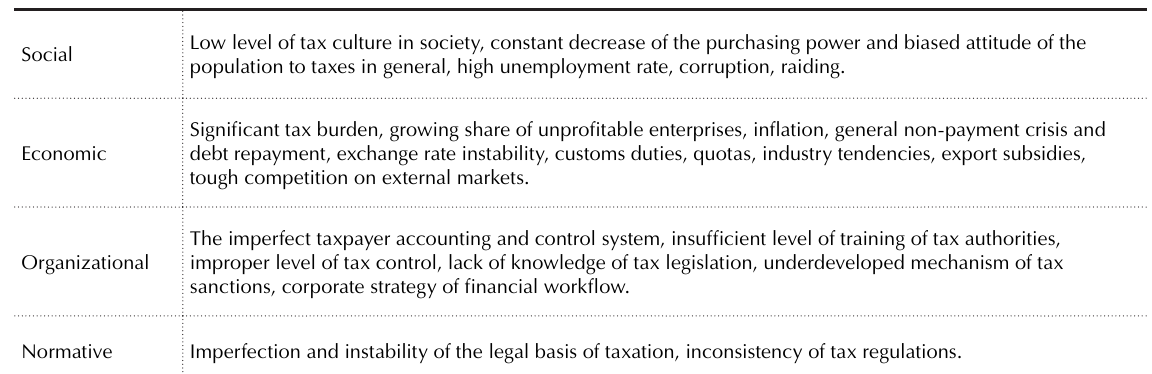
Source: made by the authors on the basis of Voronkova